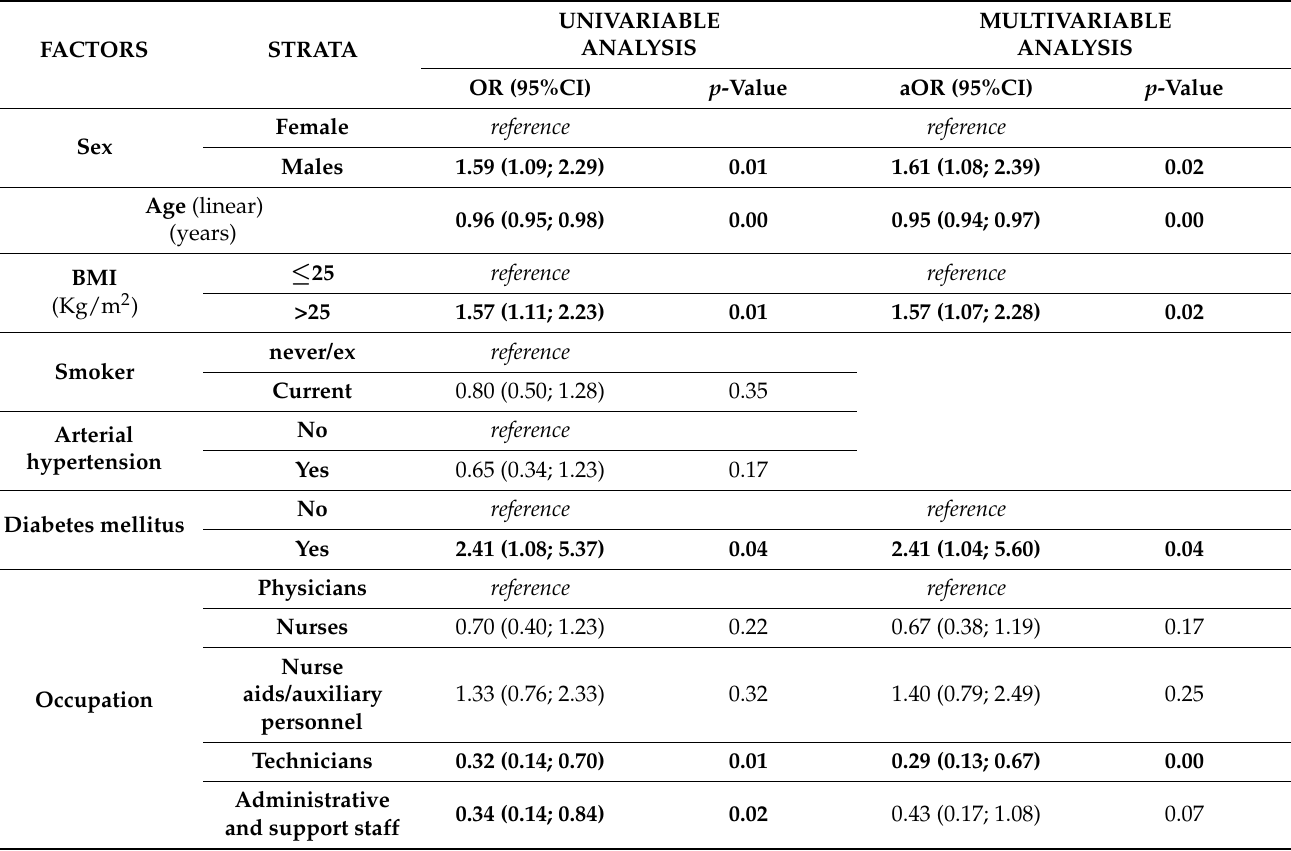
Table 4. Univariable and multivariable logistic regression analysis on the risk of SARS-CoV-2 break- through infection among vaccinated healthcare workers of Trieste hospitals. Odds ratio unadjusted (OR) and adjusted (aOR) with 95% confidence interval (CI) and stratum specific p -value. Significant estimates are reported in